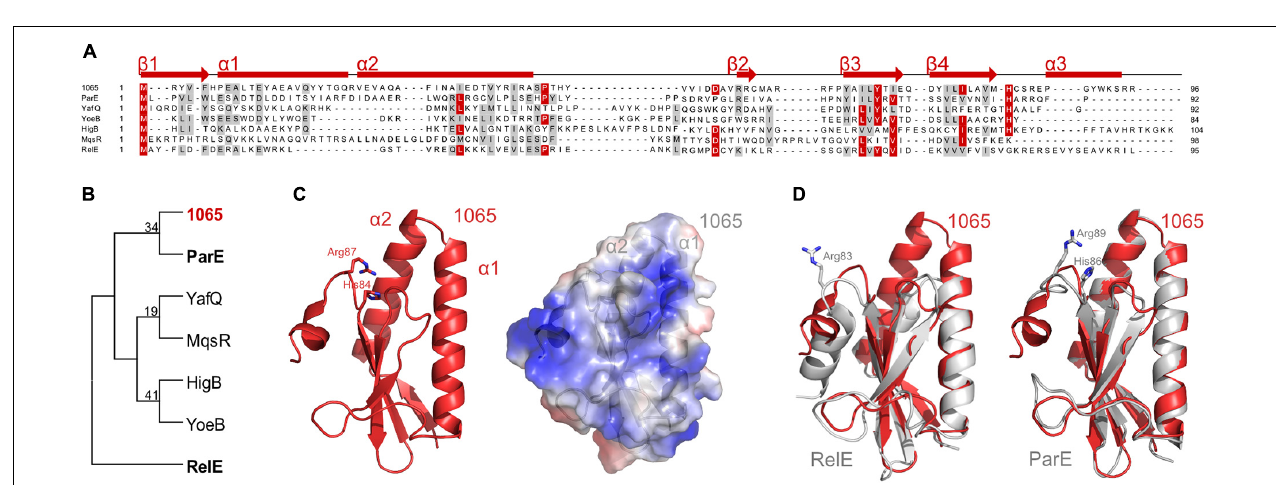
FIGURE 1 | Genomic context of the orthocaspase MaOC1 and the 1065–1067 toxin-antitoxin pair. Genes are shown in reverse orientation compared to the original sequence for clarity. (A) In Microcystis aeruginosa PCC 7806, the gene encoding the orthocaspase MaOC1 (in blue) is followed by a putative toxin-antitoxin (TA) gene pair (in red and green, respectively). The MaOC1 catalytic dyad, which is formed by His110 and Cys169, is denoted. Downstream and upstream of the TA pair, identical border repeats (in gray) are found, each containing a pair of inverted repeats (in orange). (B) The nucleotide sequence of the inverted repeat is shown as part of the border region.